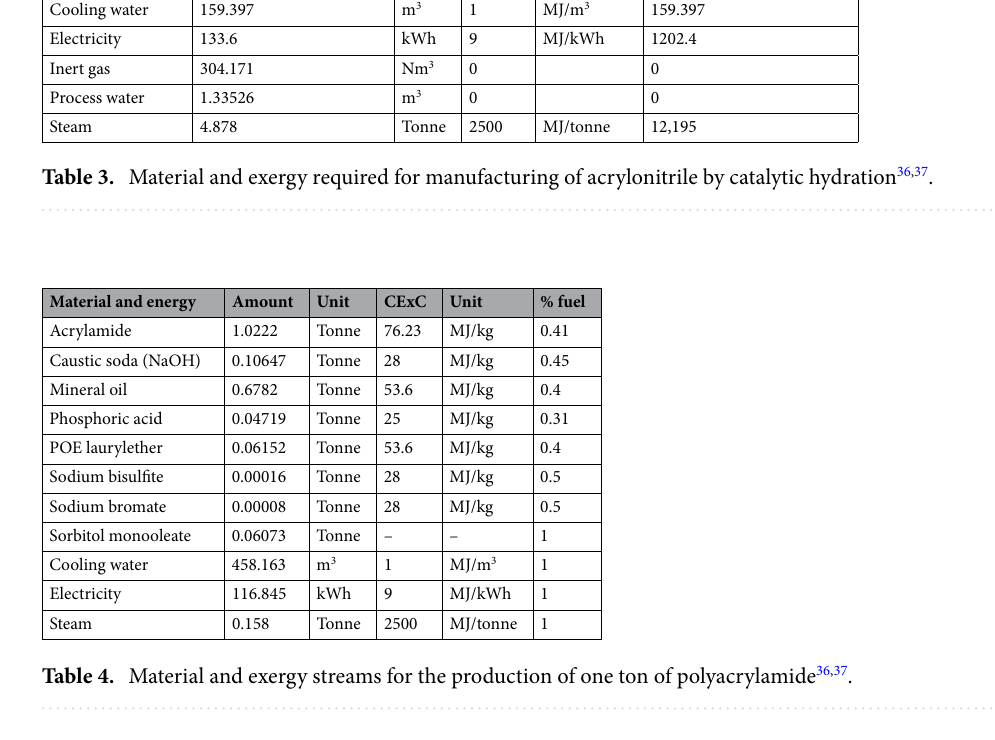
Table 4. Material and exergy streams for the production of one ton of polyacrylamide 36,37 .